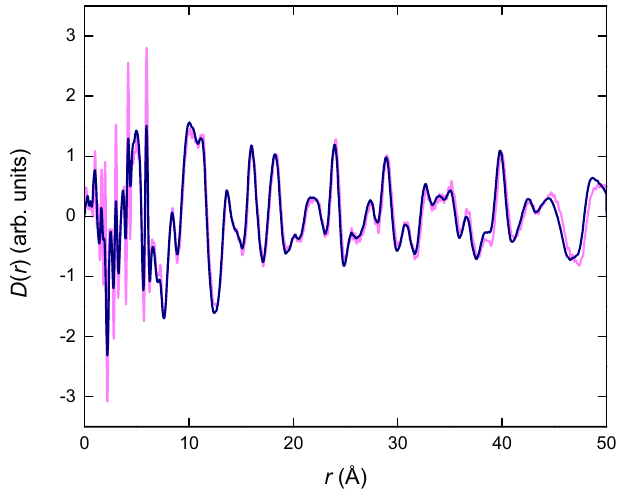
Fig. 10 Fourier transformation. Comparison between the distortion component obtained in real space (navy) and the Fourier transform of the distortion component obtained in reciprocal space